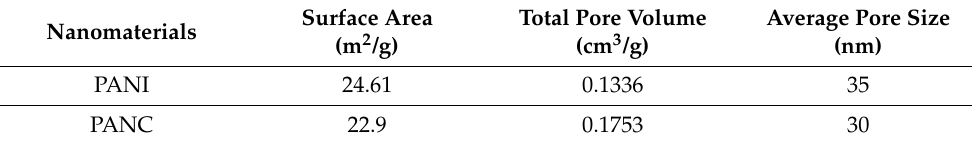
Table 1. Surface area of the PANI and PANC.